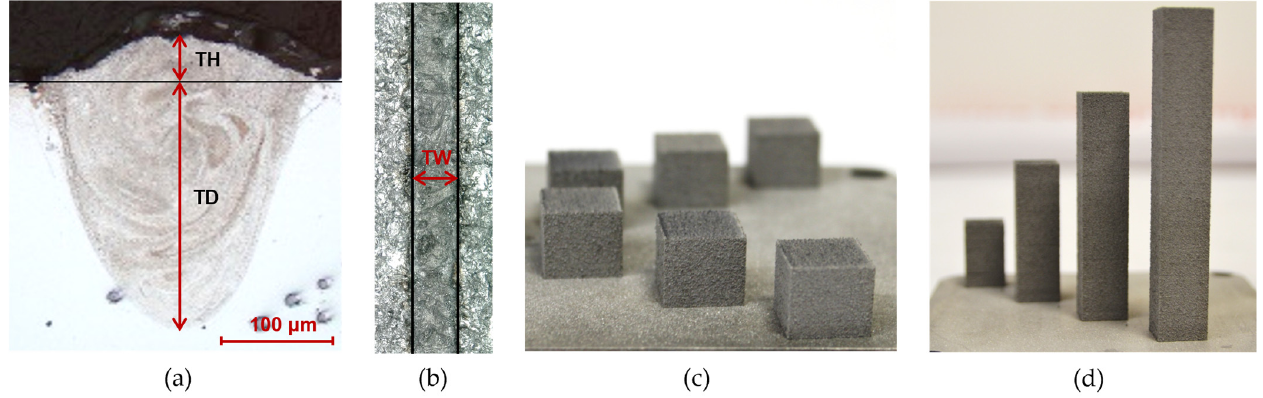
Figure 2. ( a , b ) Measured parameters of single track–track height (TH), track depth (TD), track width (TW), ( c ) bulk cube samples and ( d ) bulk cuboid samples.